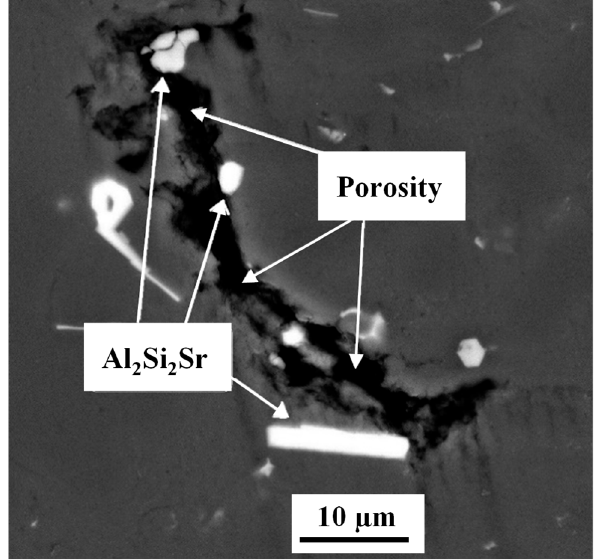
Figure 12. SEM micrograph of TS showing the formation of porosity near the Al 2 Si 2 Sr phase.